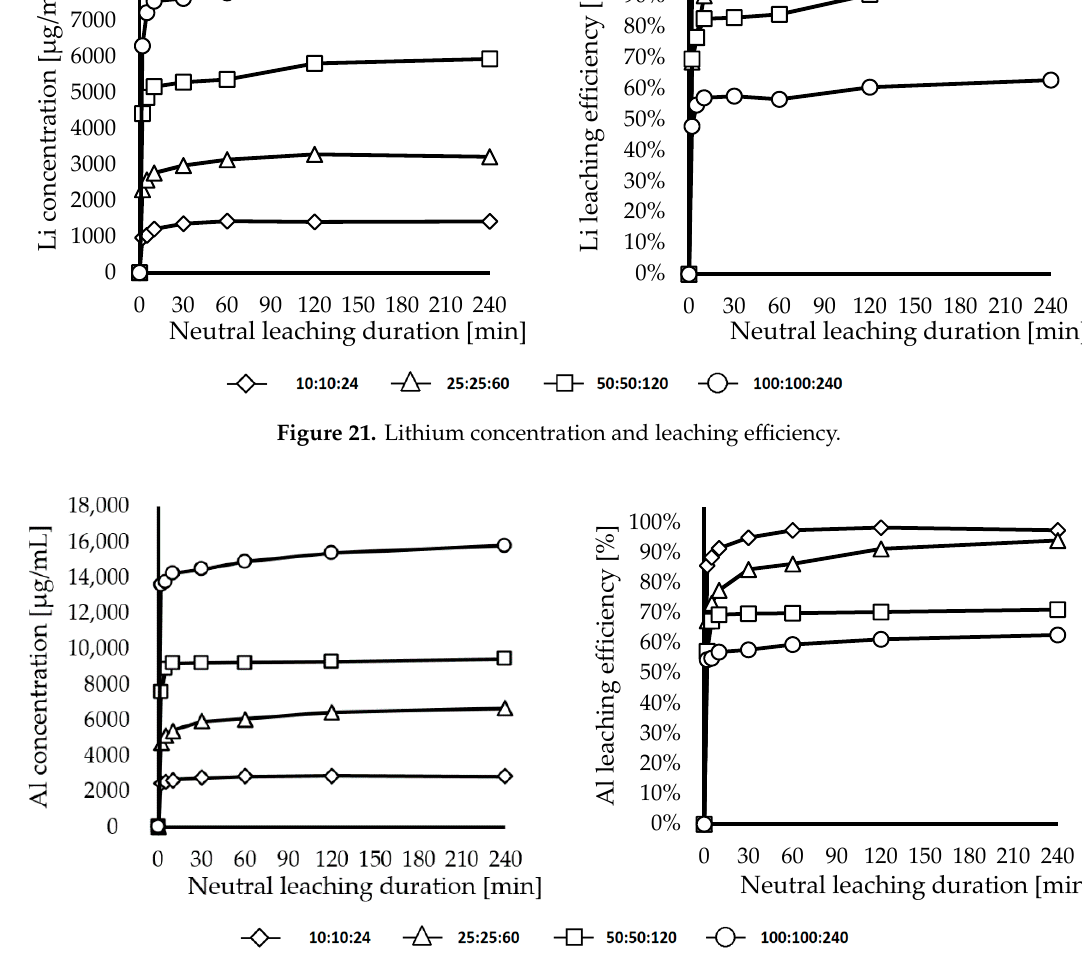
Figure 22. Aluminum concentration and leaching efficiency.